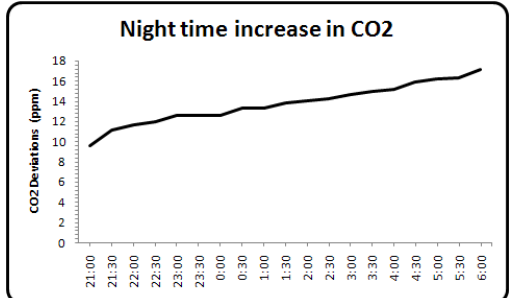
Figure.5 Night time increase in observed atmospheric CO 2 during 21 to 06 hours LT .